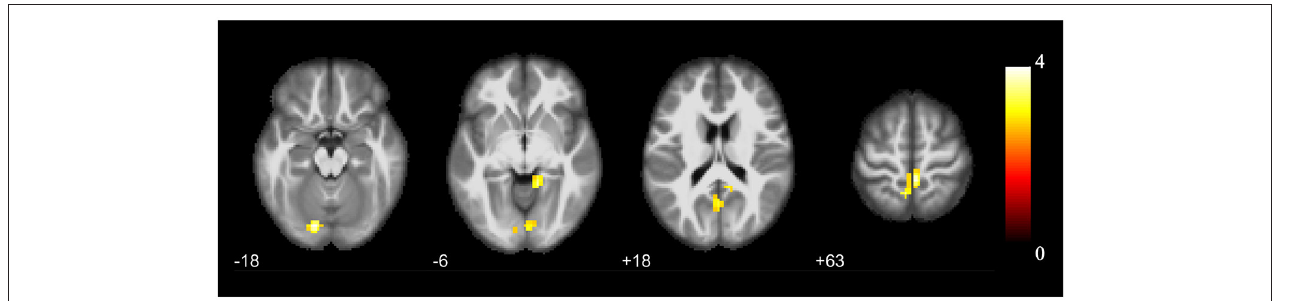
FIGURE 2 | Brain regions with increased functional connectivity to the cluster with increased GMV (parahippocampal gyrus and amygdala) in HIV + HoM compared with HIV– HoM (voxel-level uncorrected P < 0.005, cluster size > 50). The color bars indicate T -statistics.